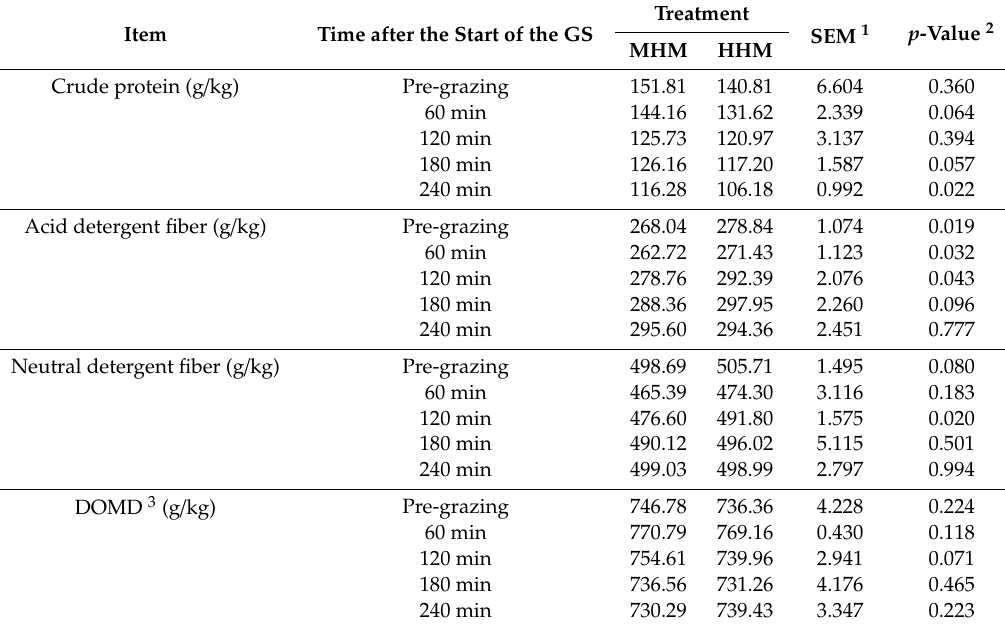
Table 5. E ff ect of medium (MHM) and high (HHM) pre-grazing herbage mass on nutritive value of the pre grazing and residual forage during the first grazing